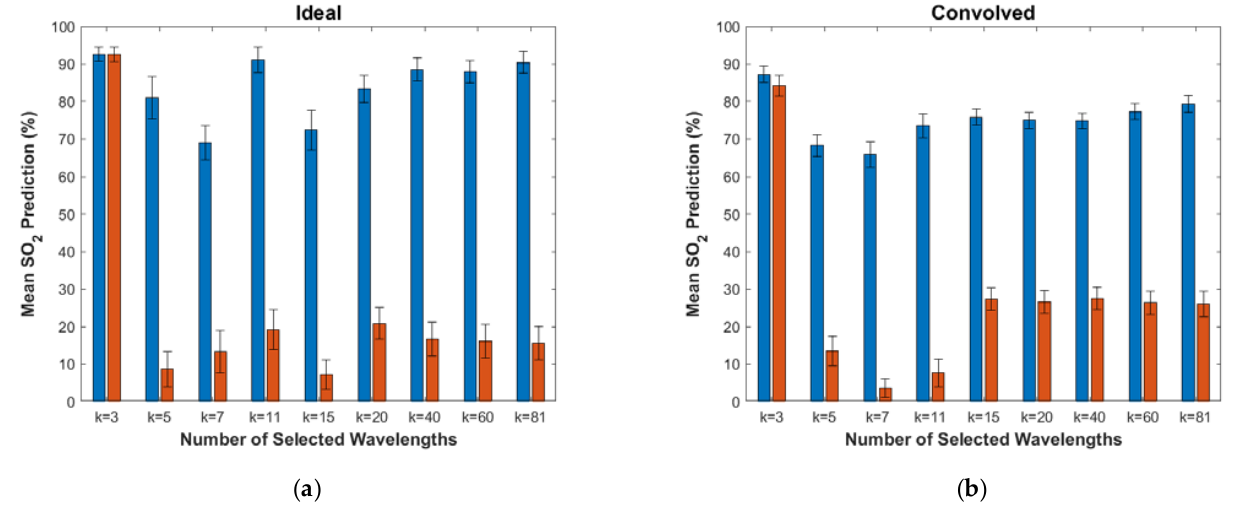
Figure 8. Mean prediction values and one-standard-deviation error bars for the in vivo dataset for the different numbers of selected wavelengths. Values for the subjects in the at-rest state are shown in blue and for the occlusion state in red. Results are given for ( a ) the ideal case and ( b ) the convolved case.